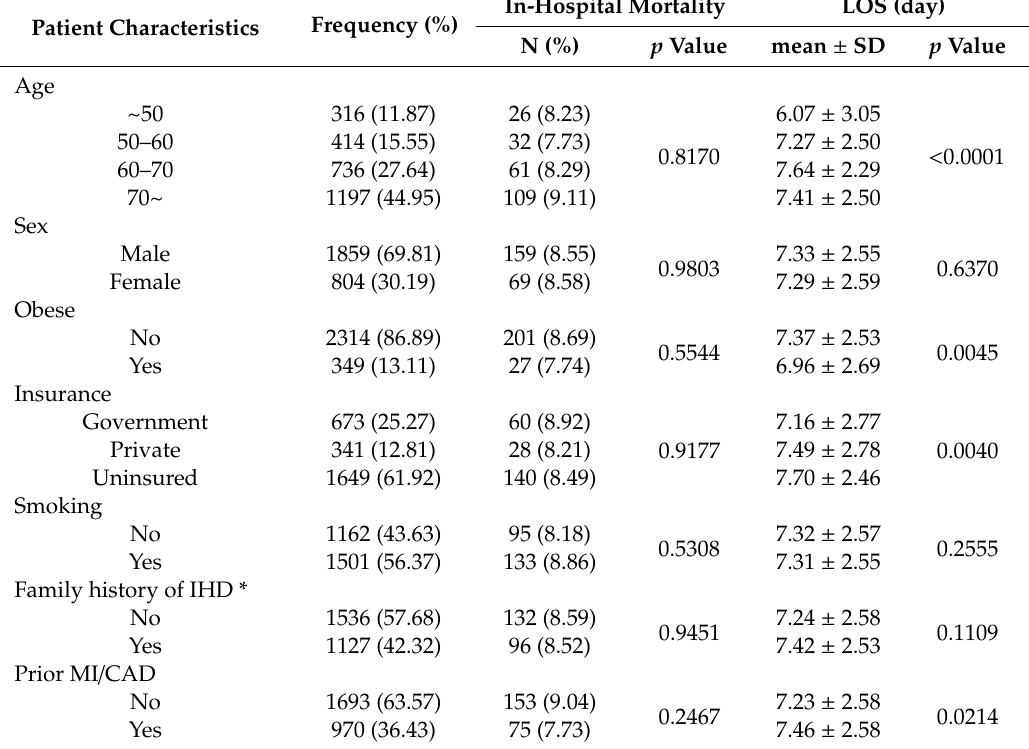
Table 1. Univariate relationship between patient characteristics and outcome